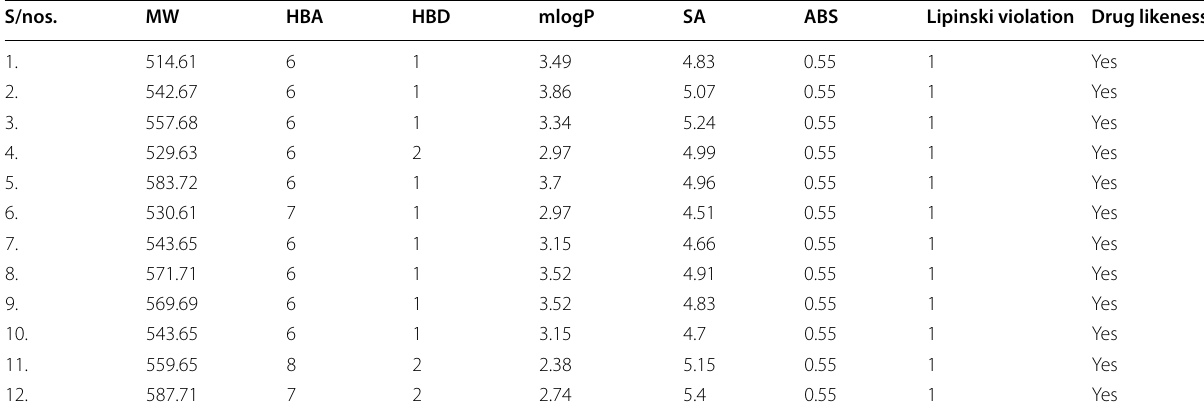
MW, molecular weight; HBA, hydrogen bond acceptors; HBD, hydrogen bond donors; SA, synthetic accessibility; ABS, Bioavailability Score